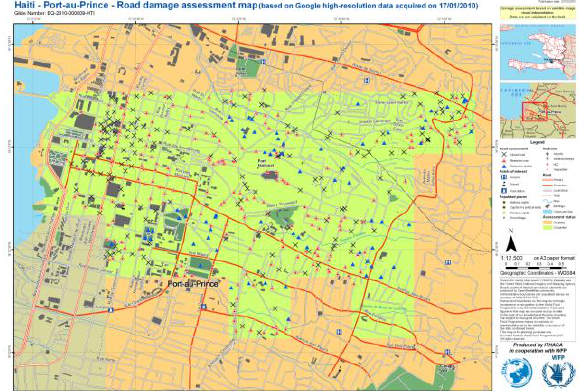
Figure 4. Haiti – Port-au-Prince: road damage assessment map as of 17 Jan 2010 (based on 0.15 m imagery)